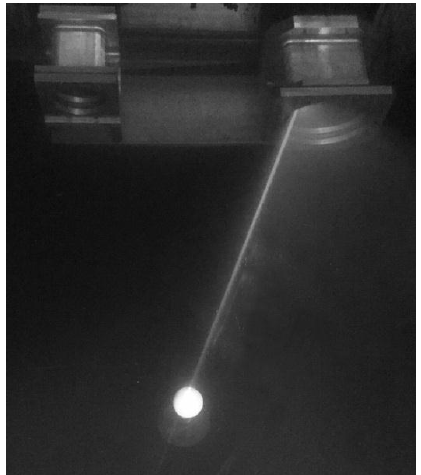
Figure 7. The standard ball measurement experimental setup in the water tank.